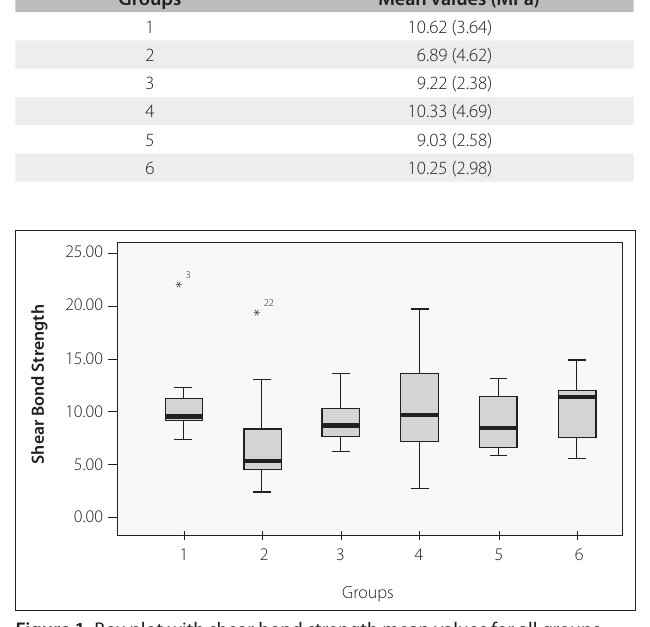
Table 1. Mean shear bond strength values and standard deviation Groups